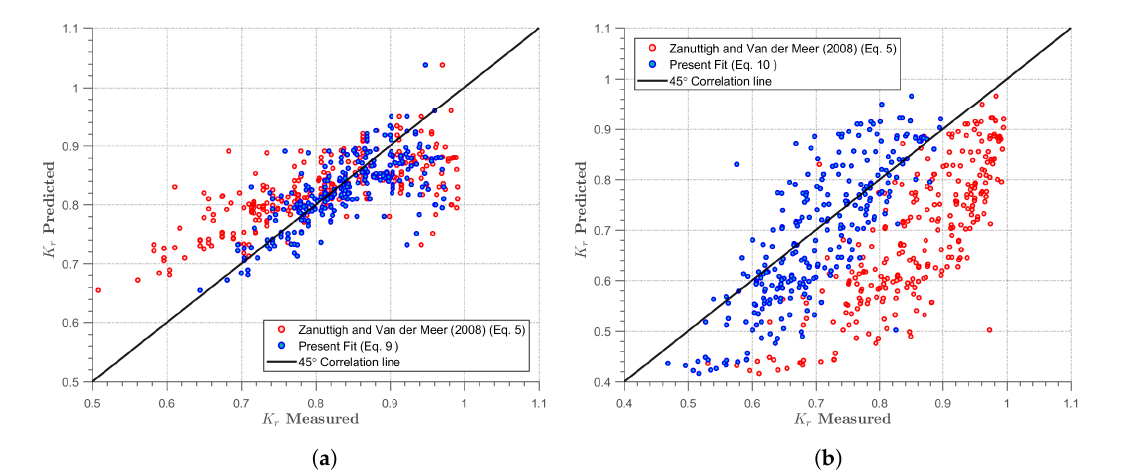
Figure 10. Comparison between the measured K r and the predicted K r of the wave reflection coefficient ( a ) cot α = 1.5; and ( b ) cot α = 3.0.